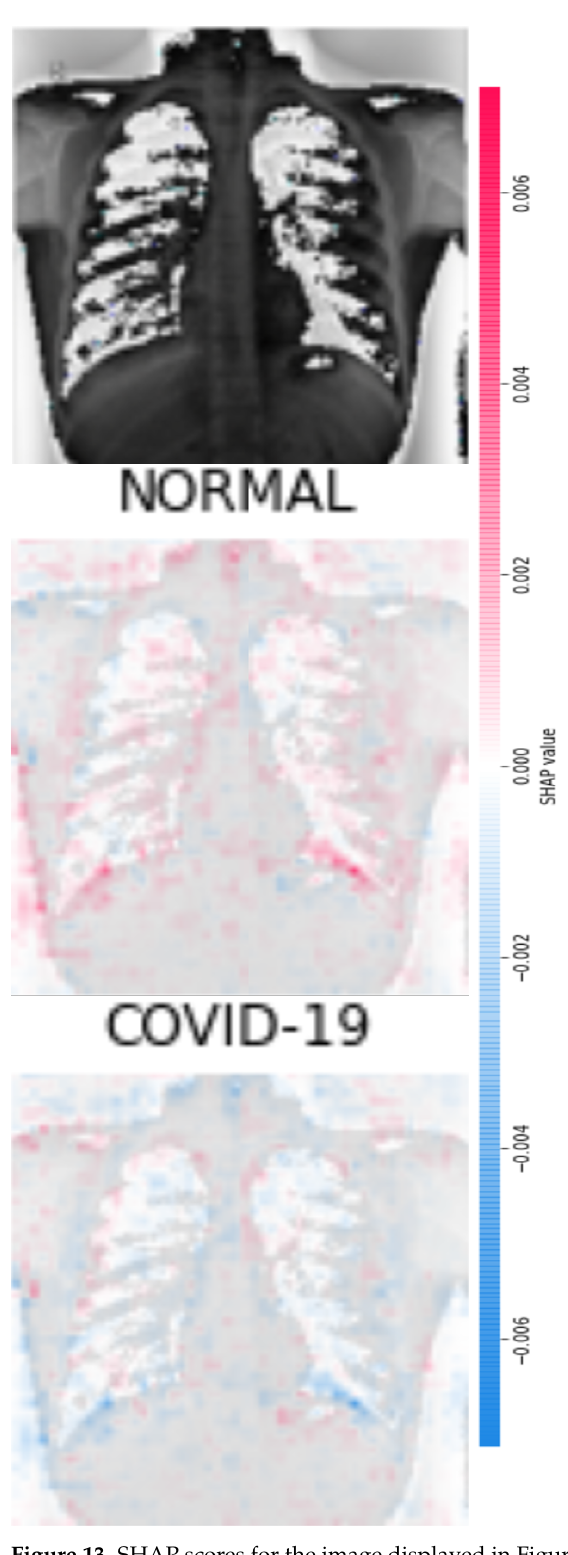
Figure 13. SHAP scores for the image displayed in Figure 9 [right]. By observing the middle plots of Figures 10–13, many colored points can be noticed in various sectors of the images. For instance, in Figure 10, clusters of magenta points (higher SHAP values) are found in the upper half of the right lung (as seen by the reader) and in the central areas of the left lung. Likewise, in Figure 13, there are high concentrations of relevant pixels in the bottom parts of the lungs. In general, we identified that clusters